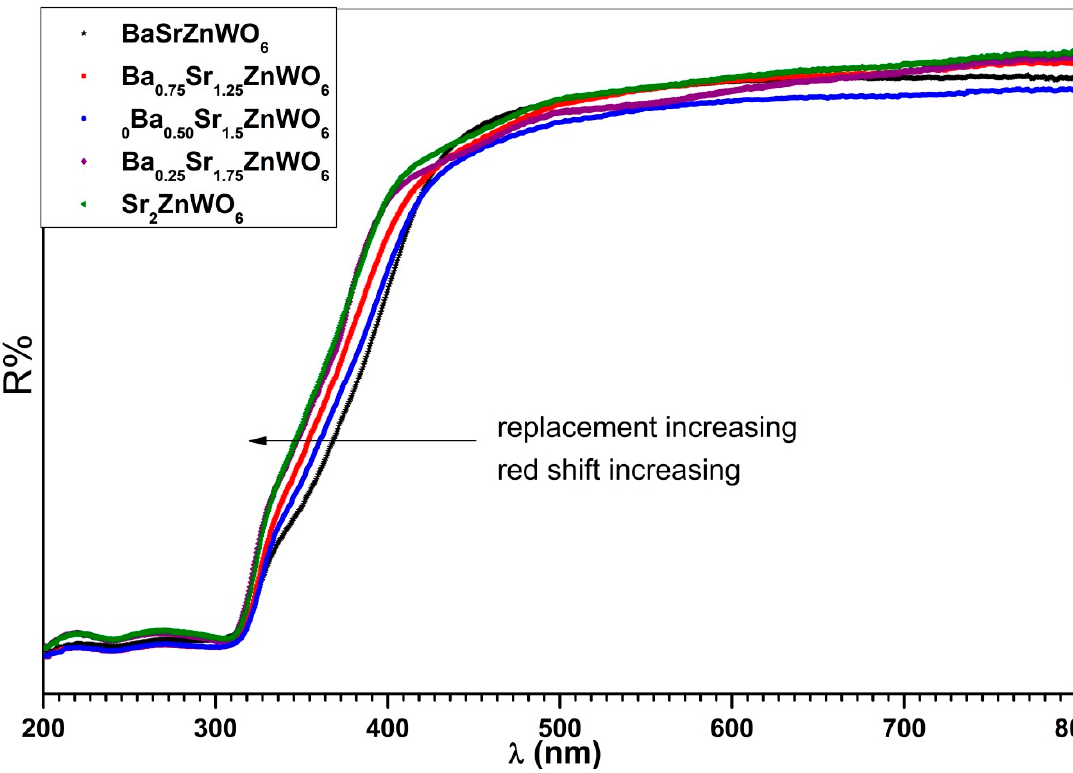
Figure 8. Diffuse reflection spectra for the Ba 2 − x Sr x ZnWO 6 (x = 1, 1.25, 1.50, 1.75, 2) double perovskite series.